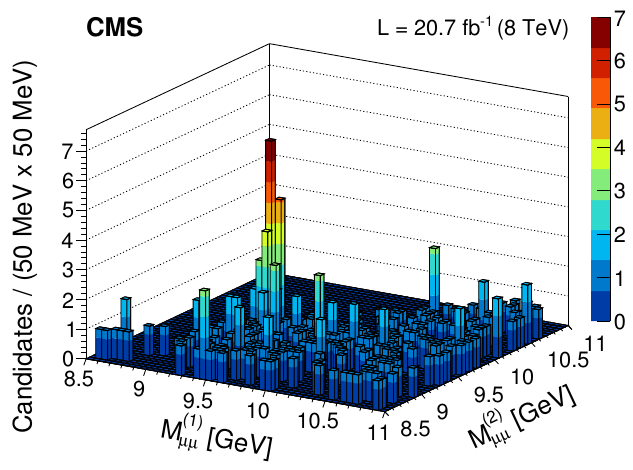
Figure 1 . Two-dimensional distribution of M (1) (cid:22)(cid:22) vs. M (2) (cid:22)(cid:22)